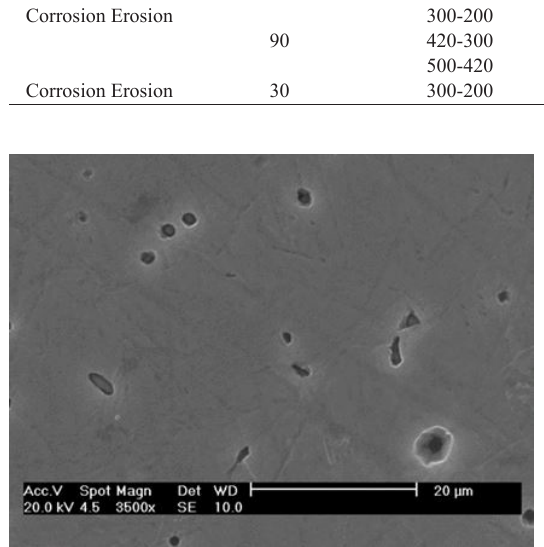
Figure 5. Image of sample surface after liquid impingement corrosion test.